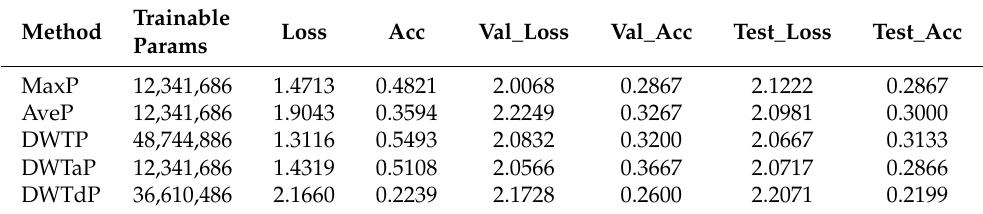
Table 7. Performance of pooling methods on FMD—Adam